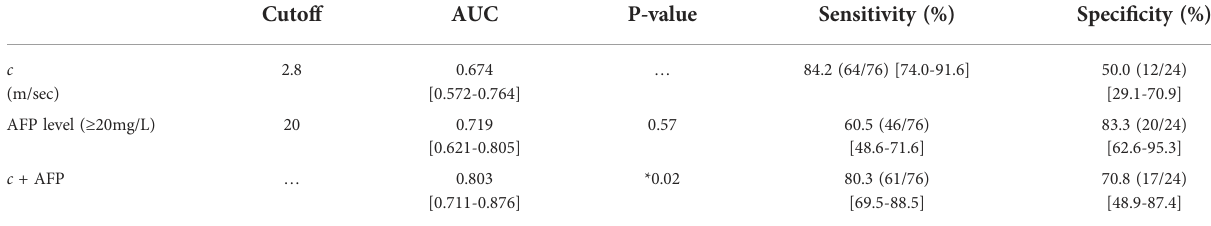
TABLE 5 Diagnostic performance of mechanical parameters c (stiffness) and serum marker AFP in detecting GPC3-positive